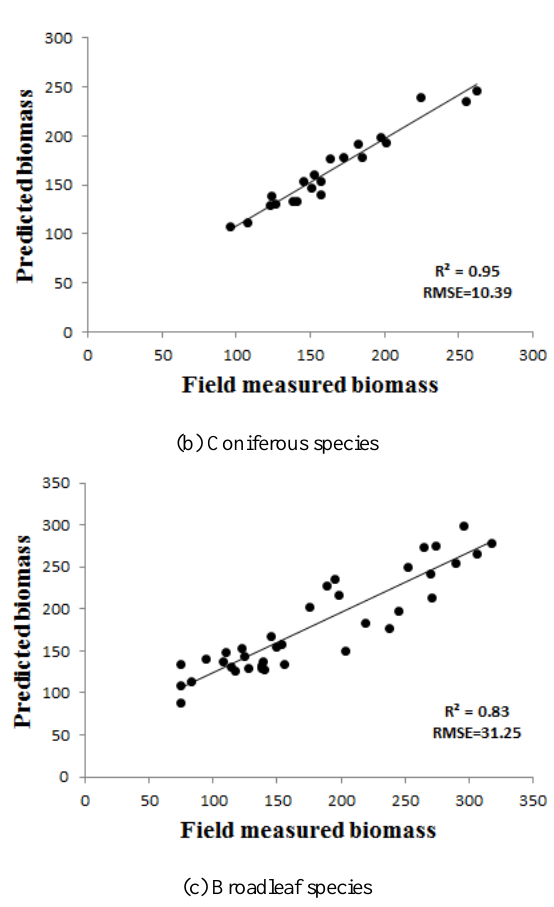
Figure 3. F ield measured AGB and lidar metrix estimation modeling